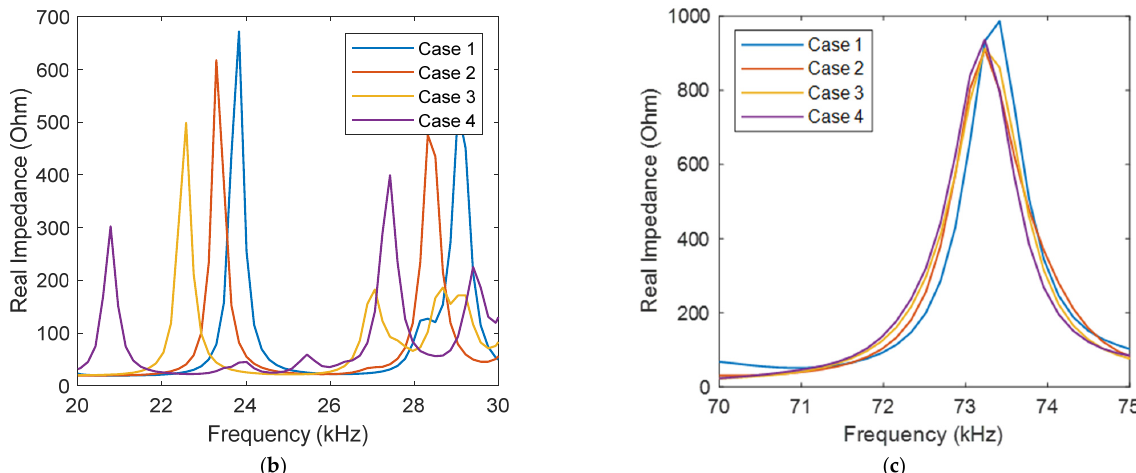
Figure 8. The real part of the numerical impedance signatures for different cases of contact stiffness. ( a ) 10–100 kHz; ( b ) 20–30 kHz; ( c ) 70–75 kHz.